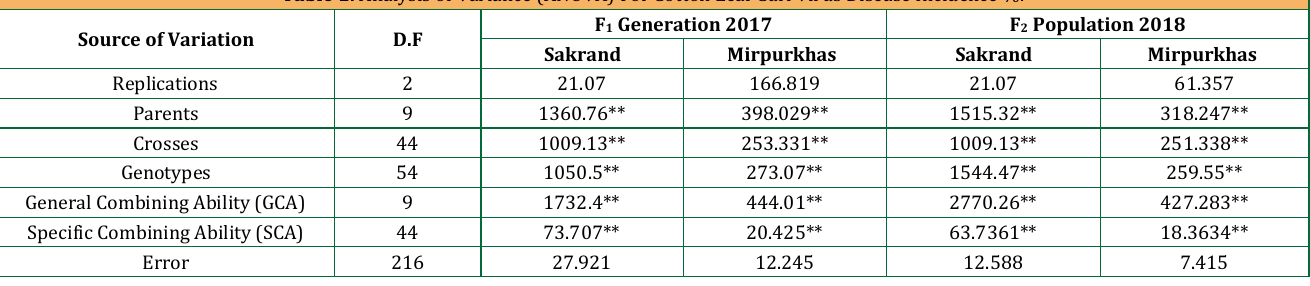
Table 1: Analysis of Variance (ANOVA) For Cotton Leaf Curl Virus Disease Incidence %.